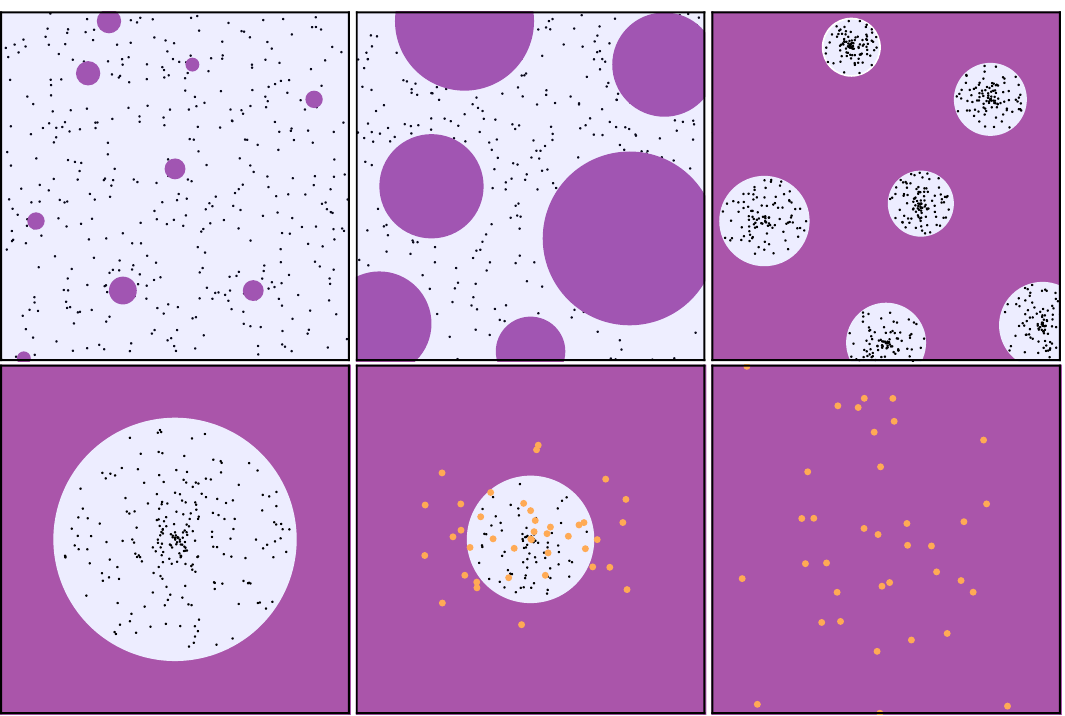
Figure 3 . Different stages of the confinement PT in the dark sector and its effect on the dark quarks. Figure is taken from refs. [48, 49]. The PT starts with bubbles of the confined phase (dark purple) nucleating inside the ambient sea of the deconfined phase (light purple). As the